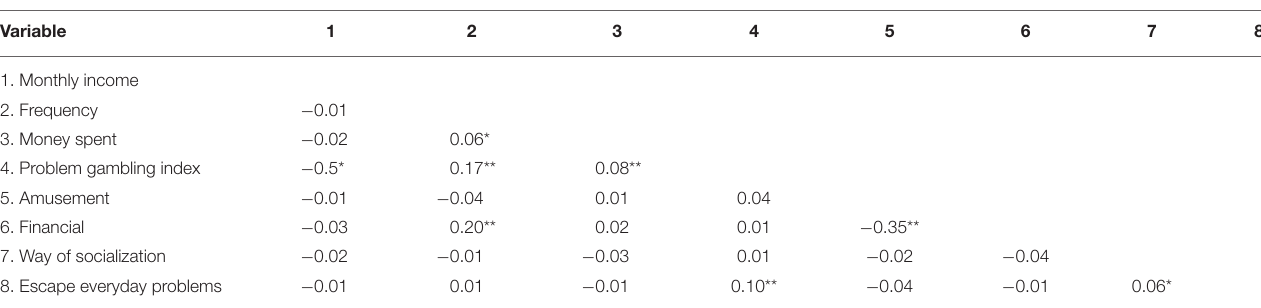
TABLE 2 | Correlation between gambling levels of involvement, demographics, gambling behaviors, and motives.